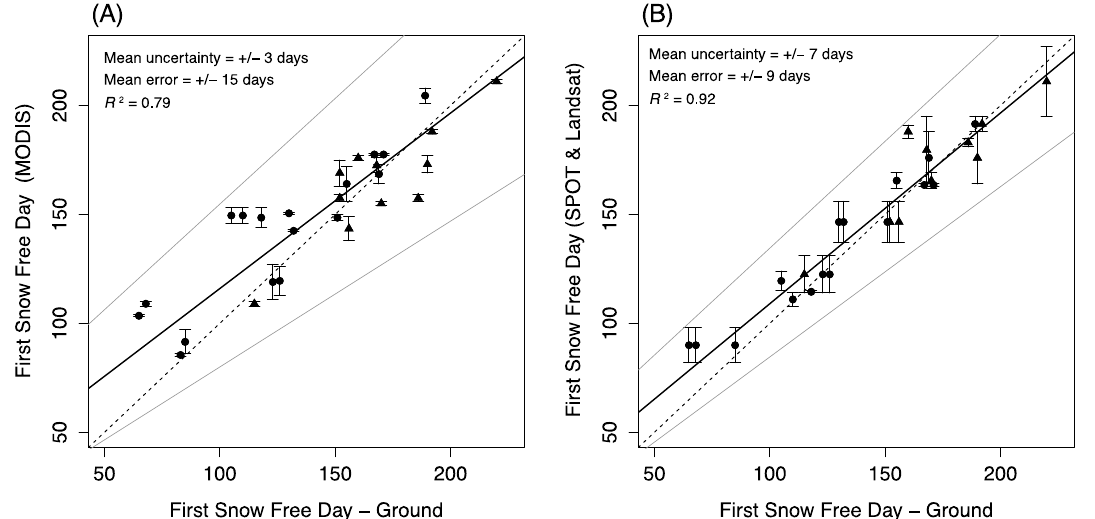
Figure 7. Ground-based measurements plotted relative to remote sensing-based estimates of the first snow free day for 28 observations in 2013 and 2015. Circles correspond to the first snow free day measured by soil temperature, and triangles correspond to first snow free day measured by snow height. Position on the y -axis represents the median Julian Day between the last snow and the first snow free observations (shown with error bars), as estimated by ( A ) MODIS; and ( B ) SPOT-5 and Landsat-8. The dashed line is the 1:1 trend line, whereas the solid line is the result of a standardized major axis regression between ground-based measurements and remote sensing observations. Grey lines indicate upper and lower confidence intervals for slope and intercept estimates.